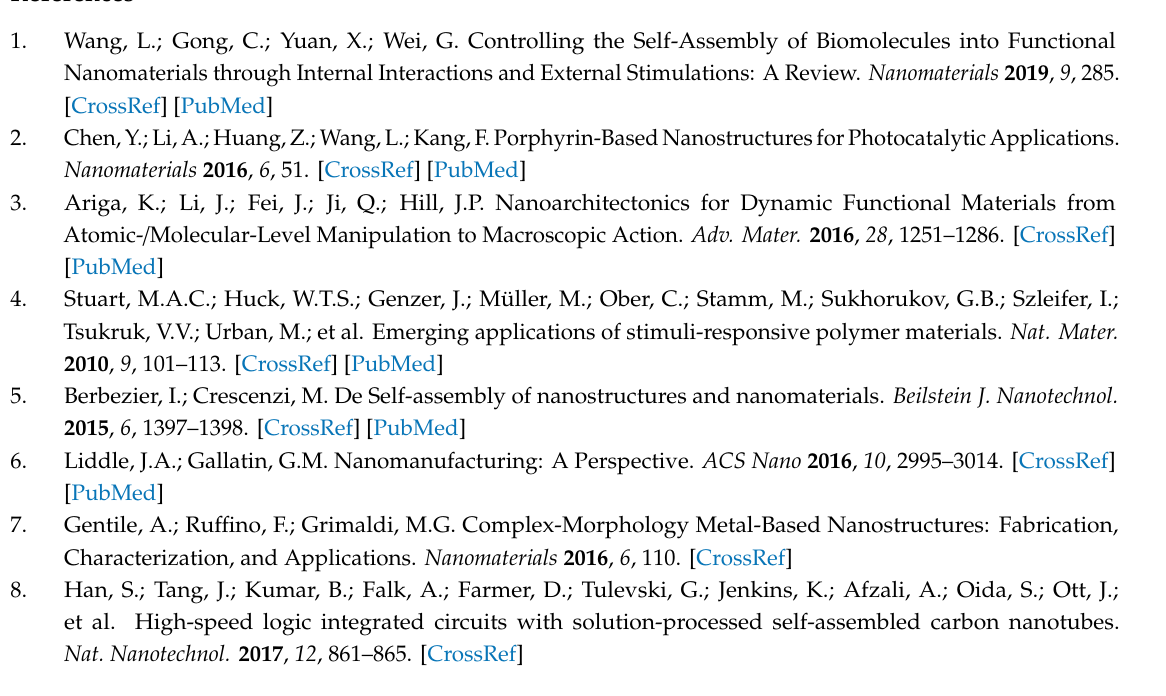
Figure S1: Color Change with Respect to Bacteriophage Concentration, Figure S2: Color Change with Respect to Electric Field